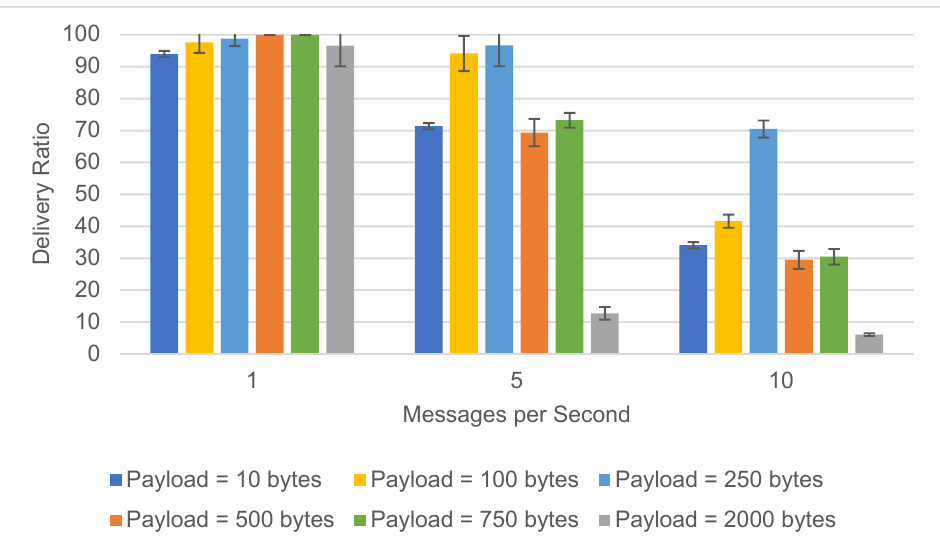
Figure 10. Delivery ratio (%) of messages (1 sensor and 1 destination, MSS = 536 bytes).